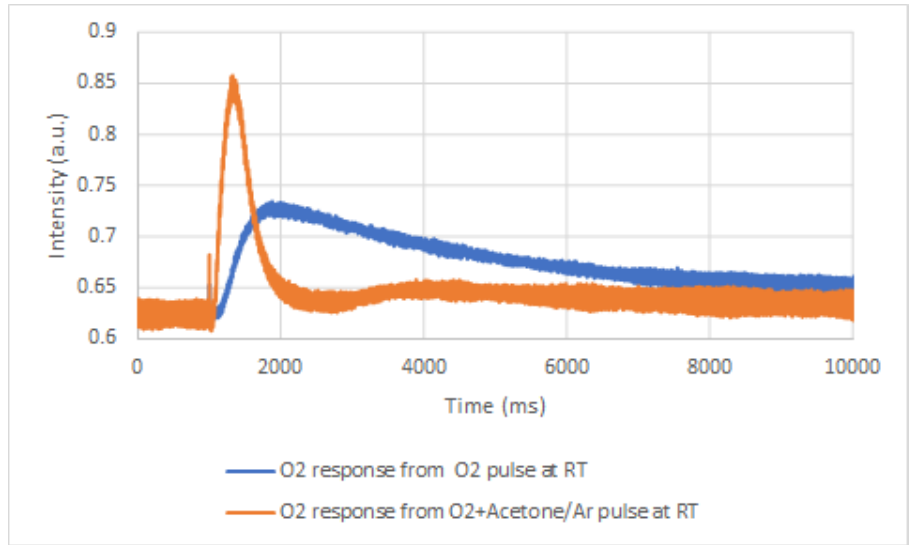
Figure 9. Oxygen response to oxygen and to oxygen:acetone/Ar mixture at RT over the 5 mg catalyst. The quantitative data supports the competitive adsorption of oxygen and acetone